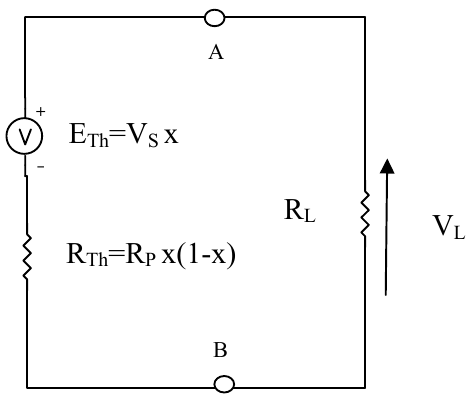
Figure 2. Equivalent circuit of sensor with primary conditioning